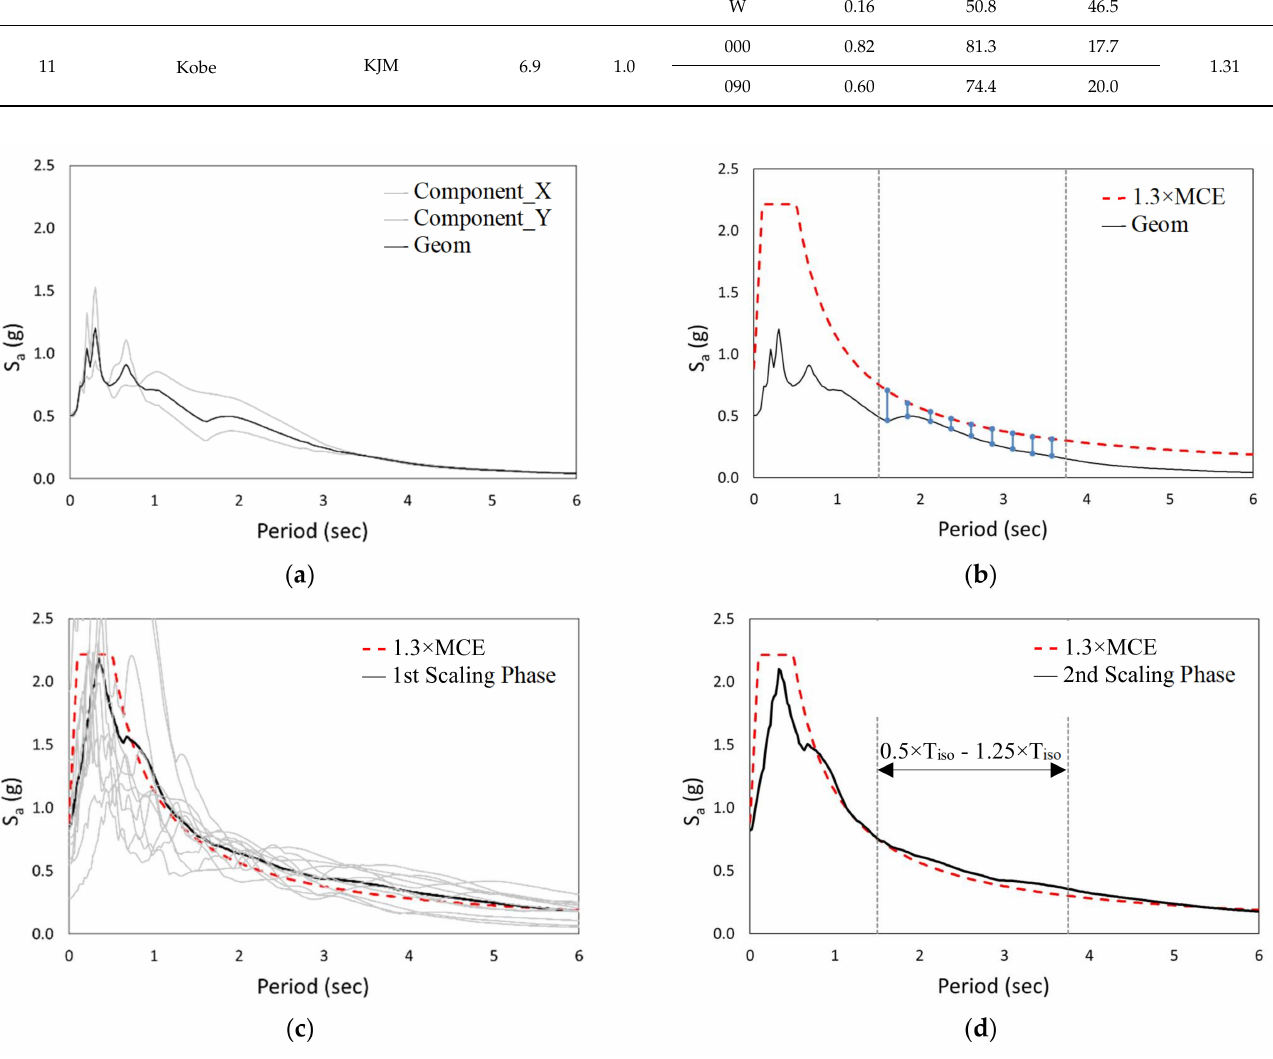
Figure 8. Scaling of earthquake ground motions: ( a ) components of an earthquake and geometric mean; ( b ) determining the error; ( c ) first scaling phase; ( d ) second scaling